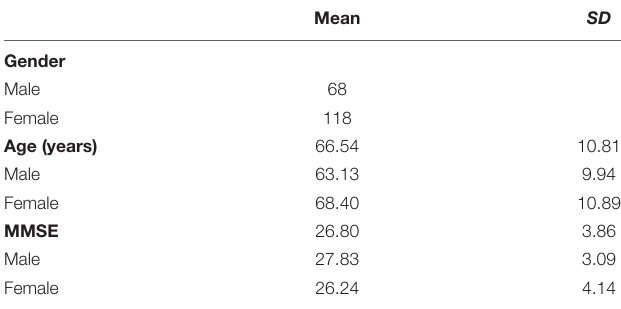
TABLE 2 | Characteristics of the older